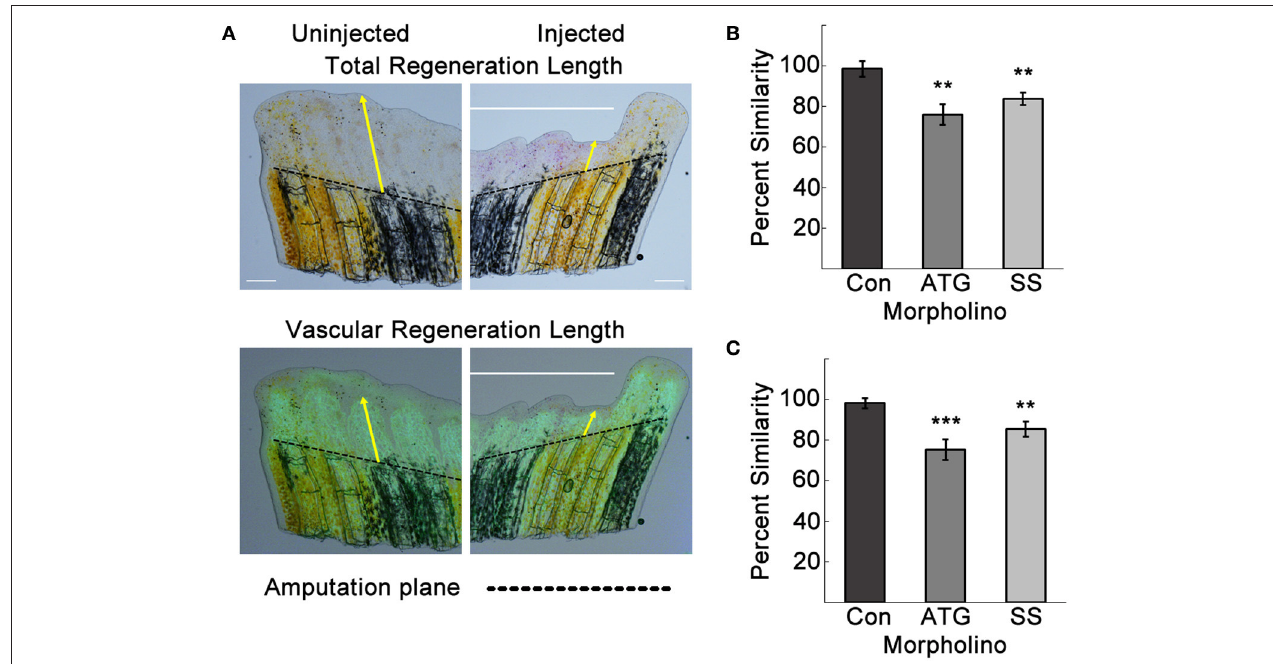
FIGURE 4 | Tmem184a knockdown results in decreased total and vascular regeneration. Total and vascular regeneration of the third fin ray of the uninjected and injected sides of each fin were measured from the amputation plane (dotted line) to the tip of the fin and the tip of the regenerating vasculature. (A) Example brightfield image and superimposed vascular fluorescence image with yellow arrows pointing out total and vascular regeneration length measurements. (B) Quantitation of total regeneration length of the third fin ray of control, ATG, and SS MO-injected fins compared to the uninjected side. (C) Quantitation of vascular regeneration length as in (B) . Graphs are shown as mean percent similarity ± S.E.M. ** p < 0.01, *** p < 0.001 compared to control. Data are representative of more than three independent experiments with at least four fish per experimental group. Scale bars = 200 µ m.